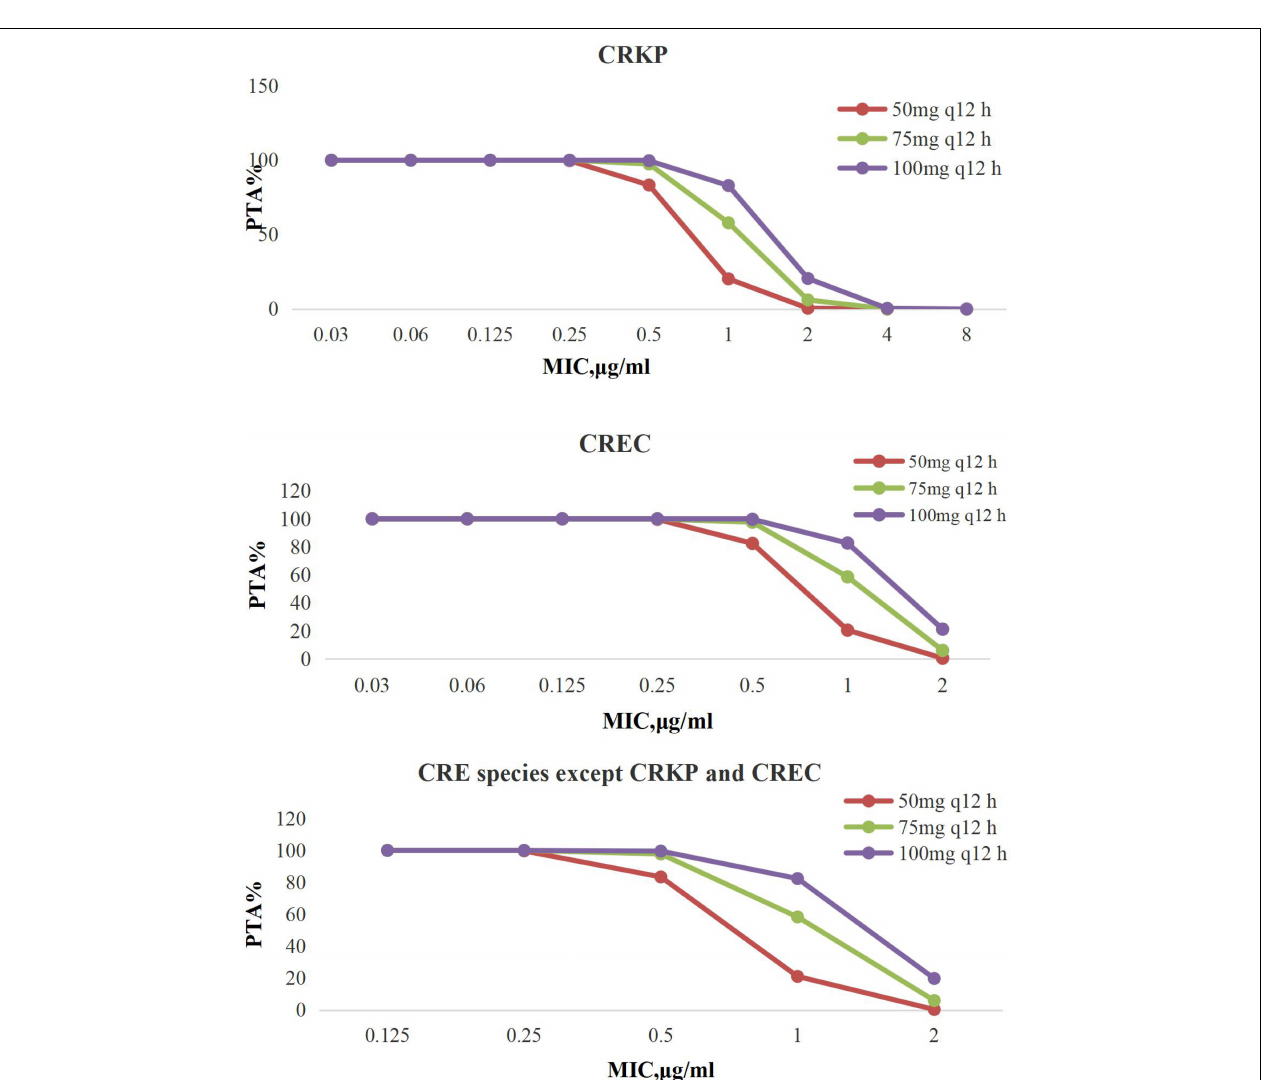
FIGURE 1 | PTA against CRE at MICs from 0.03 to 8 mg/L for tigecycline. PTA, probability target attainment; MIC, minimum inhibitory concentration; CRE, carbapenem-resistant Enterobacterales; CRKP, carbapenem-resistant Klebsiella pneumoniae ; CREC, carbapenem-resistant Escherichia coli.